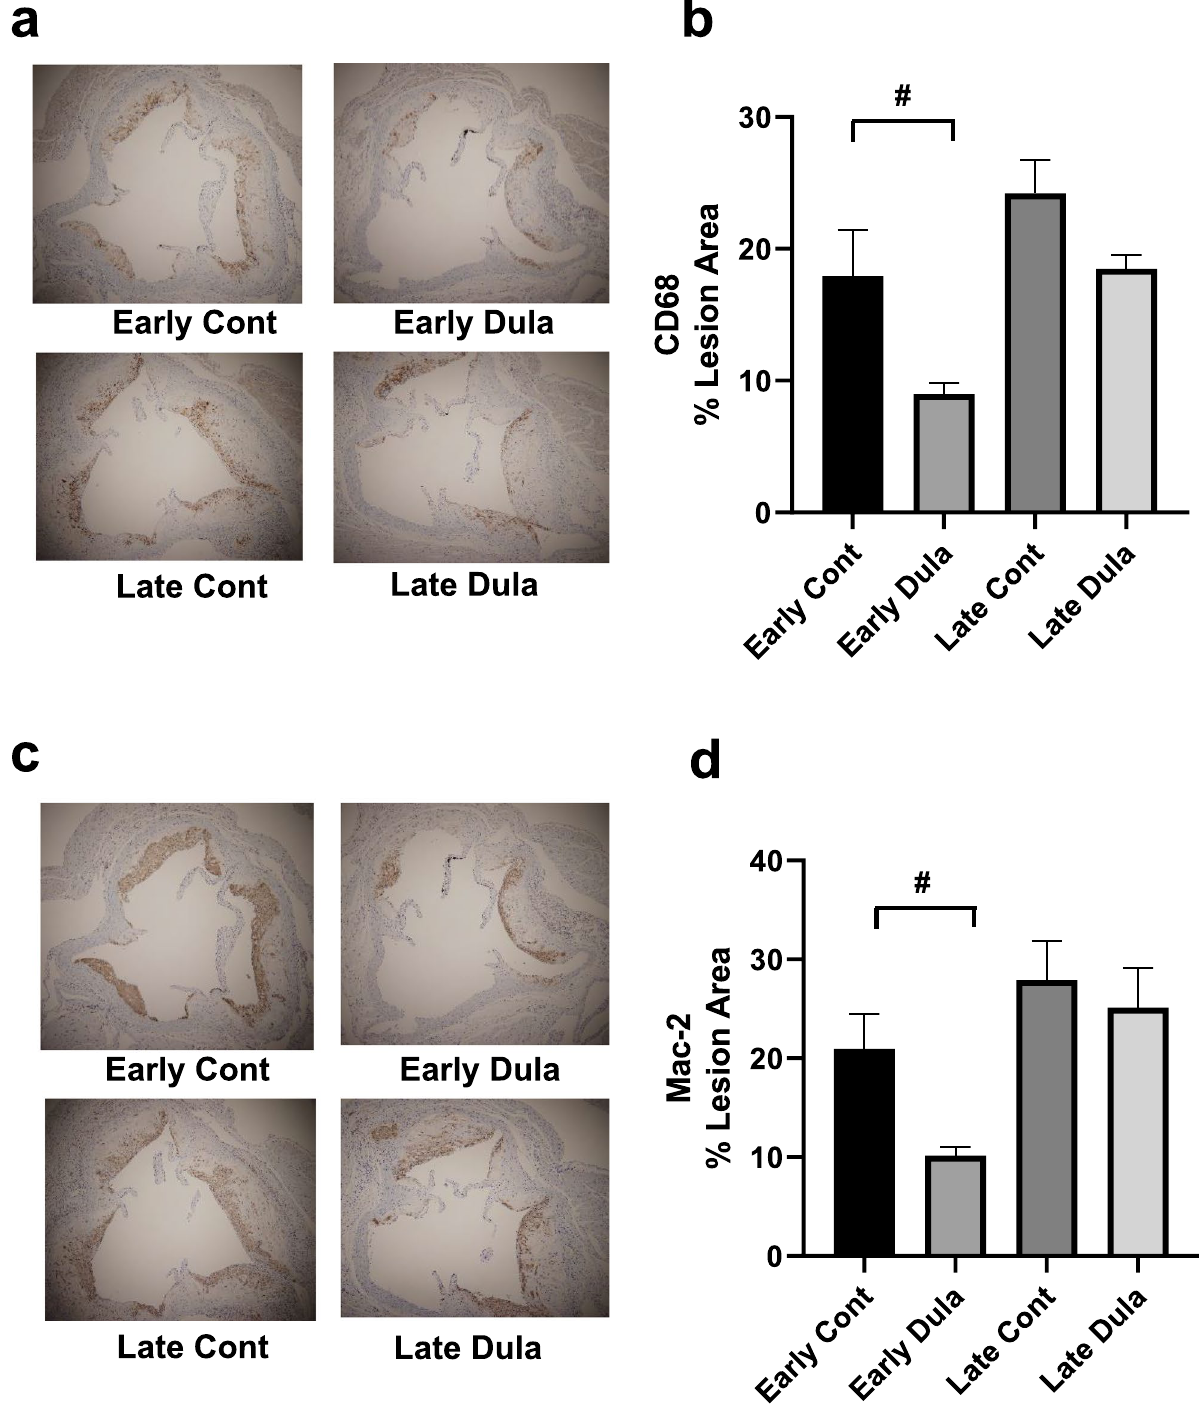
Figure 3. CD68 and Mac2 staining of aortic root in early and late intervention groups in STZ-induced ApoE knockout mice. ( a ) Representative CD68 staining pictures, ( b ) CD68 positive area (% lesion area), ( c ) Representative Mac2 staining pictures, ( d ) Mac2 positive area (% lesion area). Early Cont (n = 5–6), Early Dula (n = 5–6), Late Cont (n = 6), Late Dula (n = 6). # p < 0.05 (Early Cont vs Early